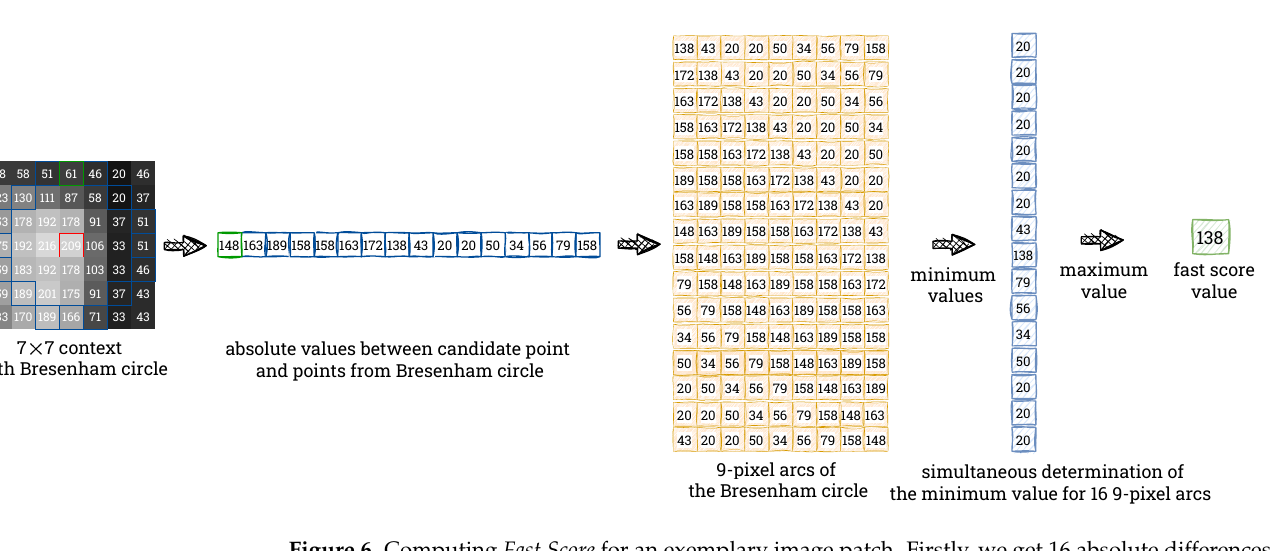
Figure 6. Computing Fast Score for an exemplary image patch. Firstly, we get 16 absolute differences between the intensity of the centre pixel and the intensities of the pixels on the Bresenham circle. From computed values we form 16 arcs (all possible) with the length of 9 pixels and find the minimum in each arc. Fast Score is the maximum from the obtained